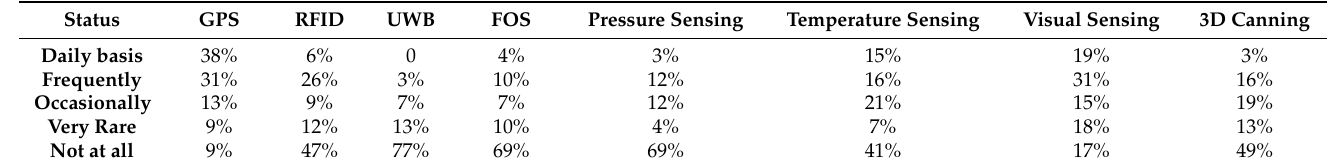
Table 3. Current status of various sensing technologies in infrastructure construction.